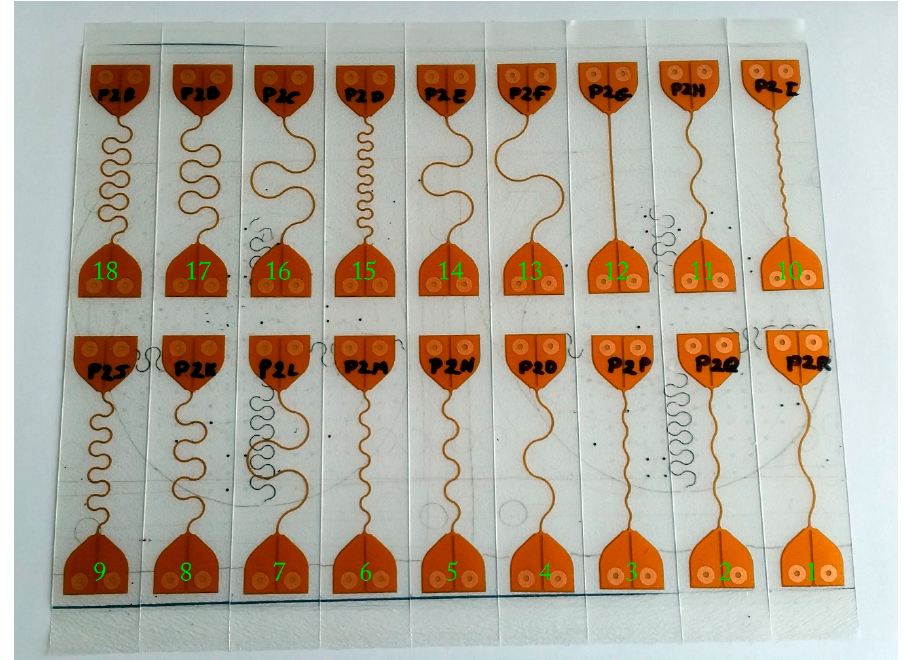
Figure 4. Meander test samples encapsulated in thermoplastic polyurethane using a vacuum press. The black debris visible on the sample originates from FCBs previously cut on the same carrier board.